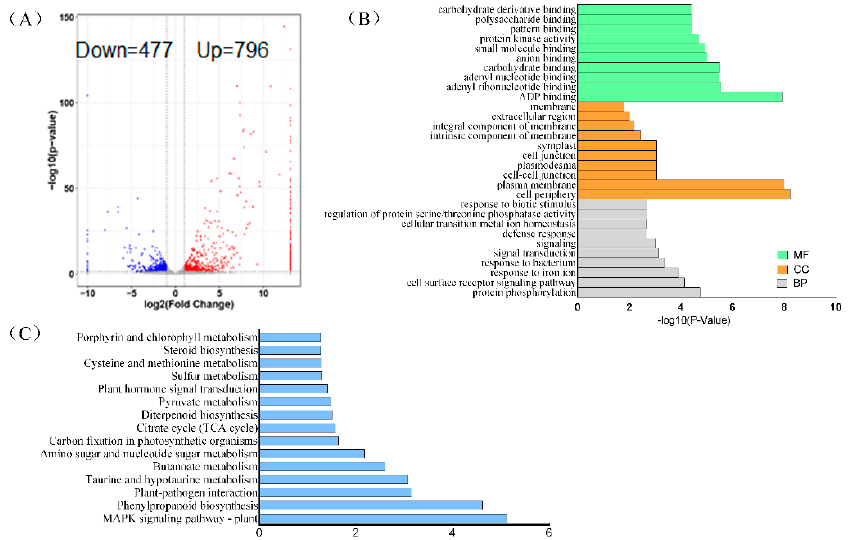
Figure 8. RNA-Seq analysis ostbp2.2 and WT-DJ under PEG treatment. ( A ) The number of DEGs identified by the RNA-seq results. ( B ) Functional GO analysis of DEGs. According to the results of GO enrichment analysis of differentially expressed genes (DEGs), GO classification is performed according to molecular function (MF), biological process (BP) and cell component (CC), and the top 10 GOs are selected to be the most significant enrichment term entries for display. The standard of significant enrichment is p -value < 0.05. ( C ) Results of KEGG enrichment analysis of